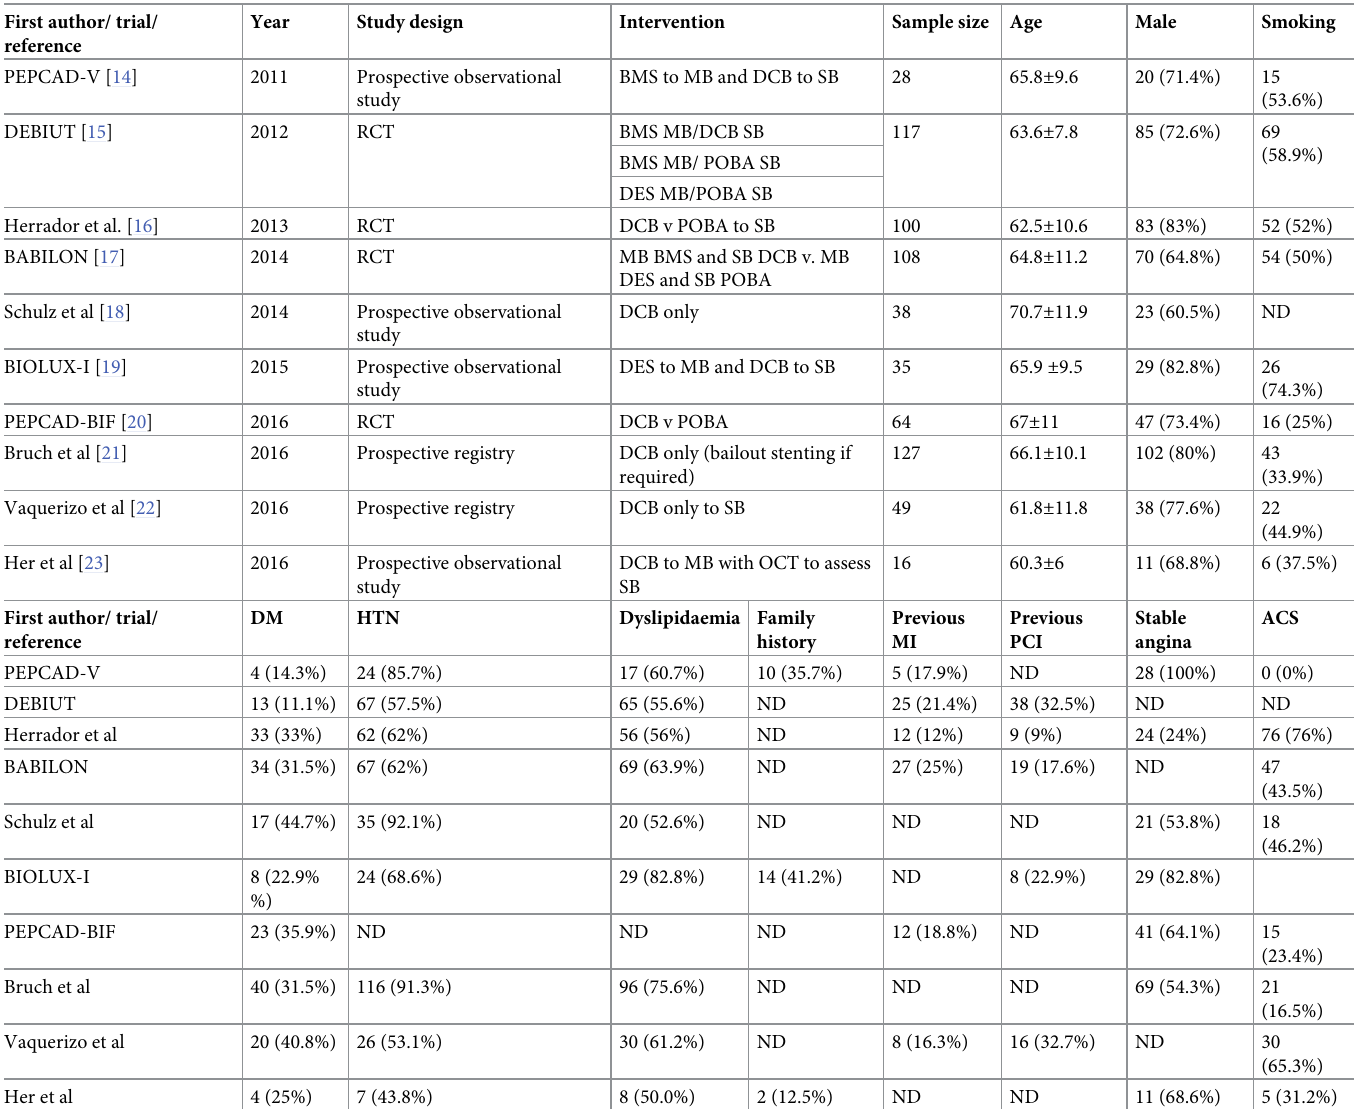
Table 1. Patient characteristics for all included